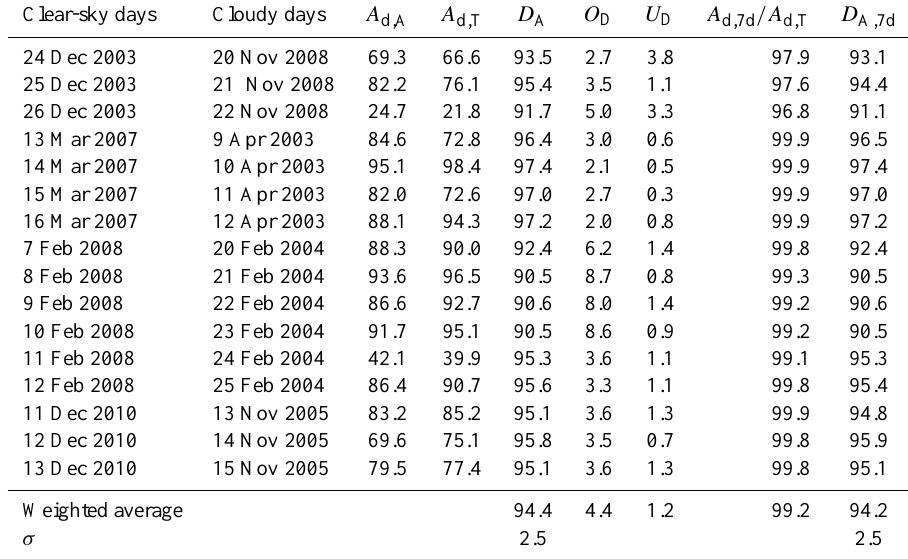
Table 11. Overall accuracy of the cloud removal methodology tested using spatio-temporal additional cloud masks (MOD10A1 SCA of 24 December 2003 is replaced with MYD10A1 SCA since data are not available). Values are compared to the performances of a basic 7-day temporal filter. Values in